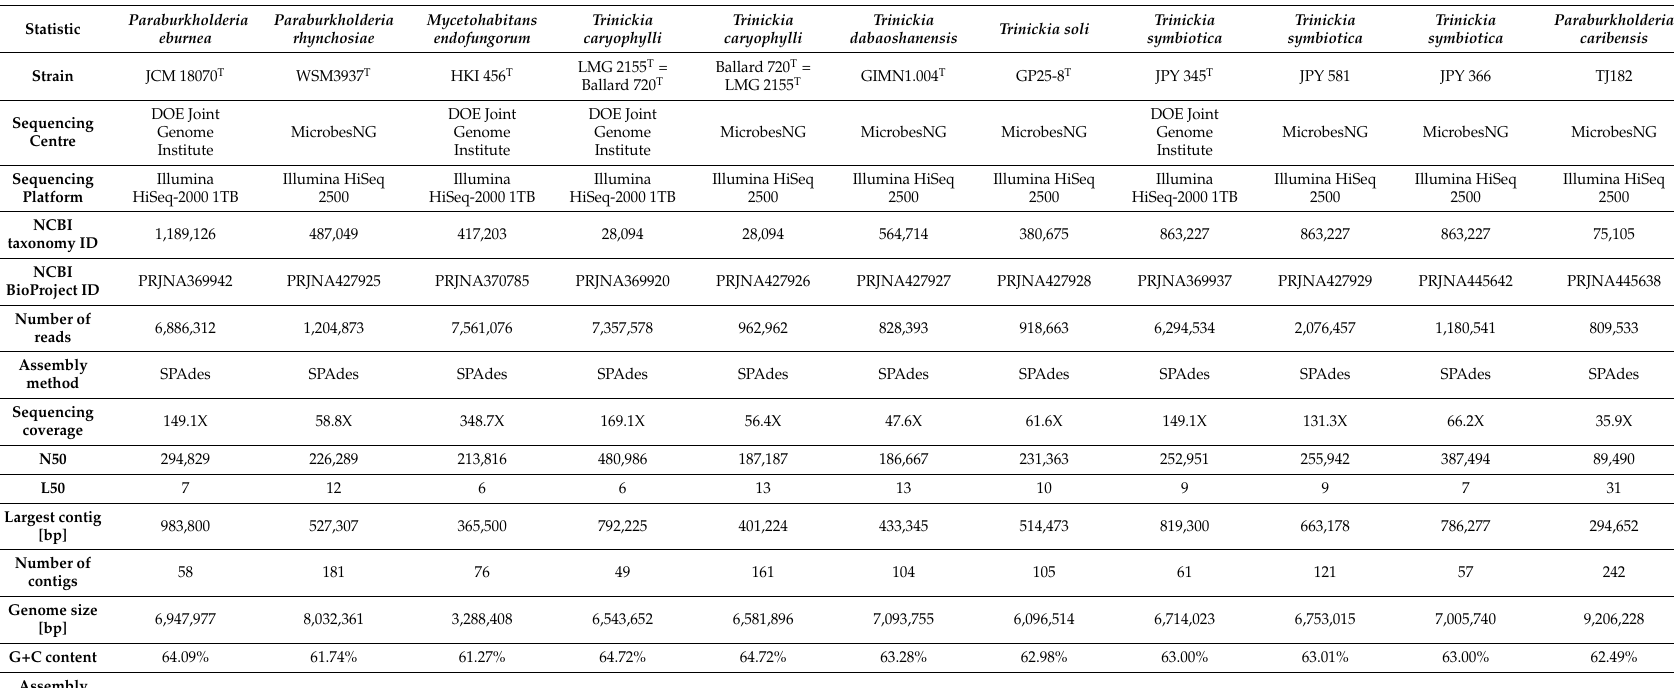
Table 1. The genome sequencing statistics for Burkholderia sensu lato strains sequenced in this